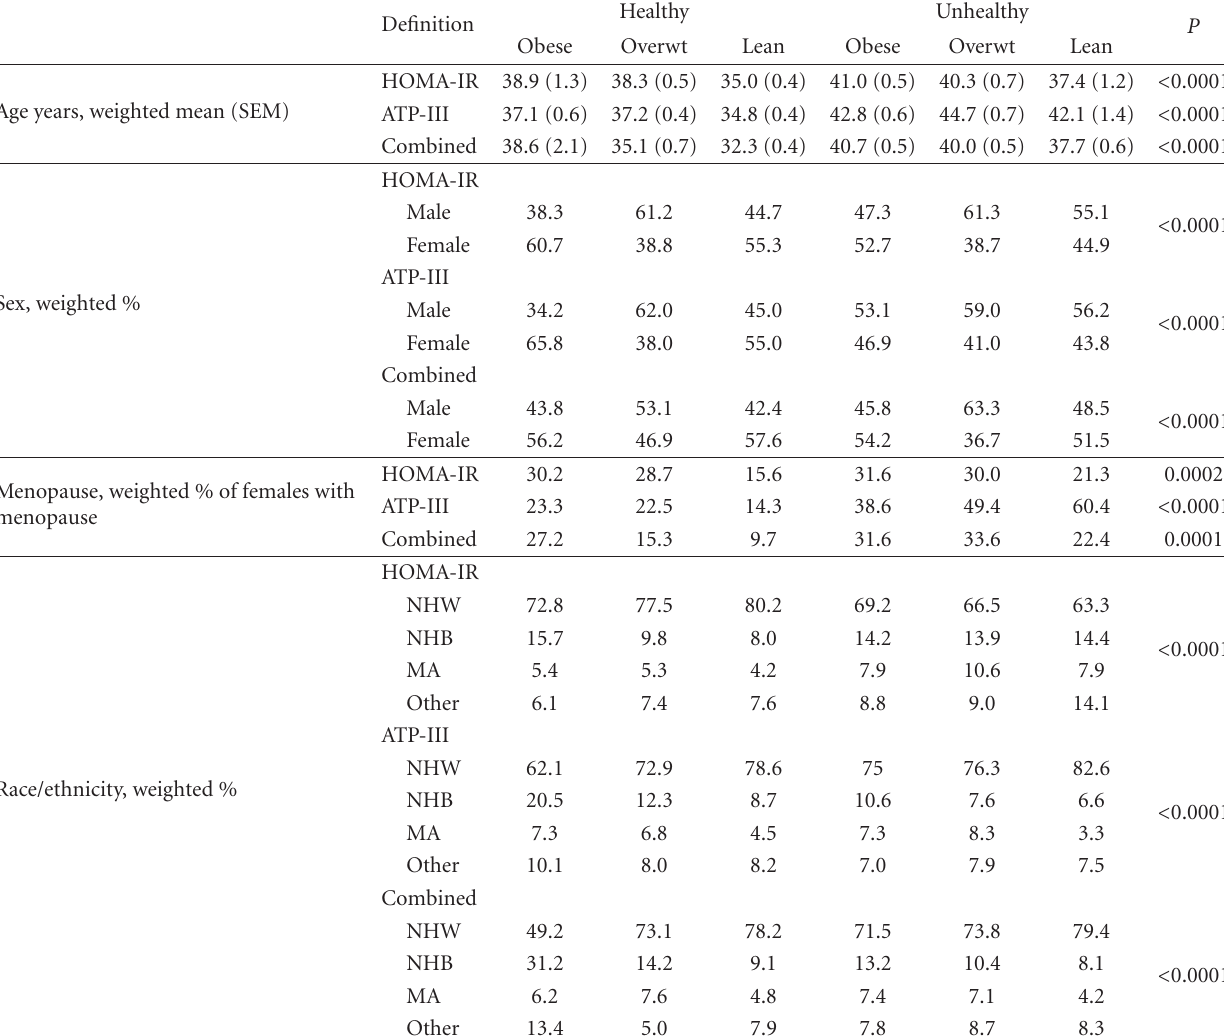
Table 3: Demographic characteristics by metabolic health and body mass index